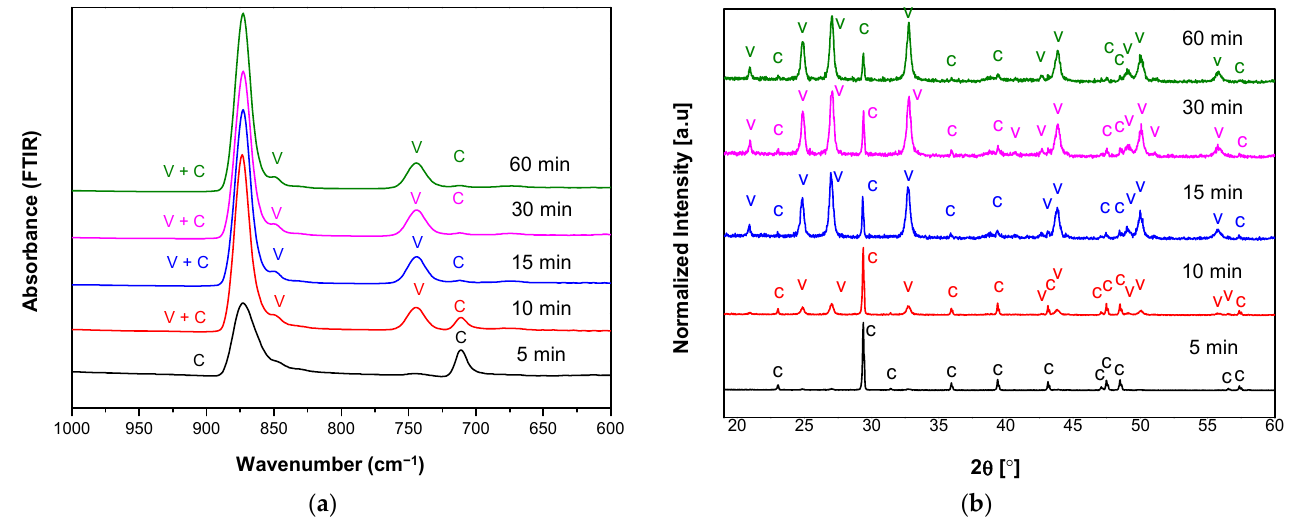
Figure 5. ( a ) FTIR and ( b ) XRD spectra of vaterite synthesized at 27 °C for different reaction times (5–60 min) at stirring speed 800 rpm. Polymorphs main peak is indicated (V = vaterite, C = calcite).